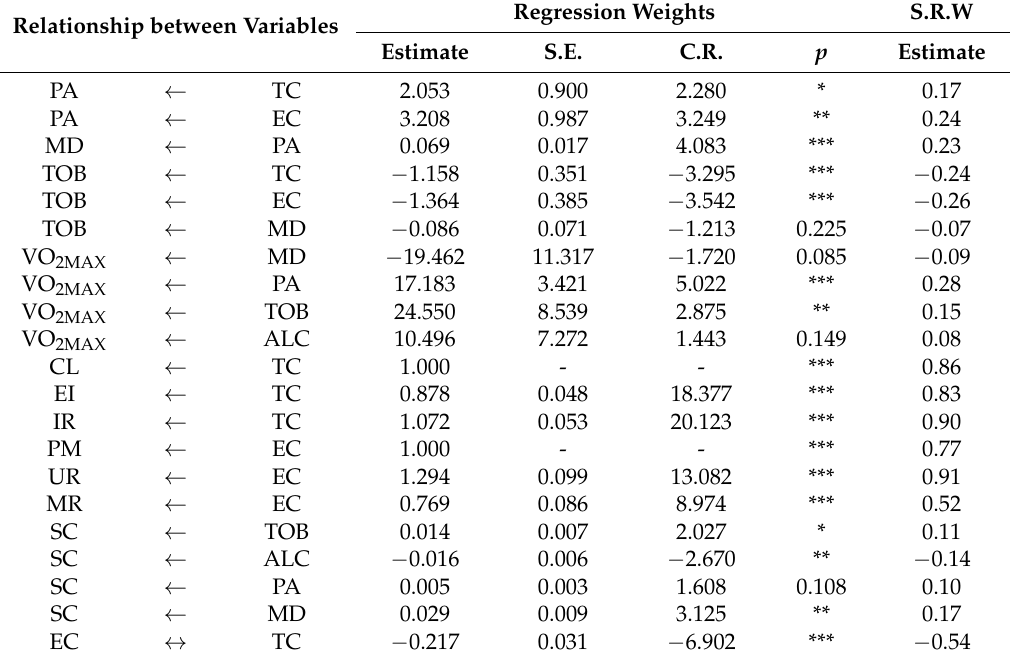
Table 2. Weights and standardized regression weights for women.